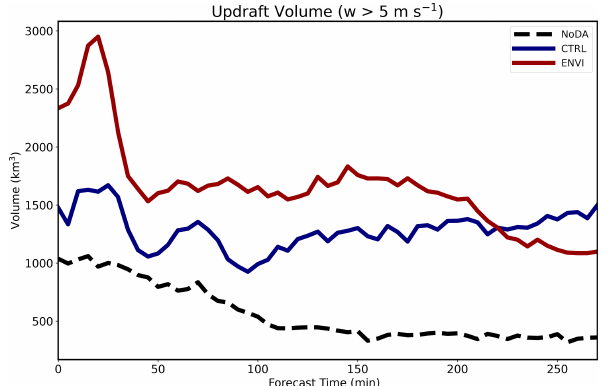
Figure 13. Ensemble mean updraft volume during the forecast pe- riod. Statistics only consider regions where the updraft velocity ex- ceeds 5ms − 1 . Dashed black, solid blue, and solid red lines corre- spond with NoDA, CTRL, and ENVI,